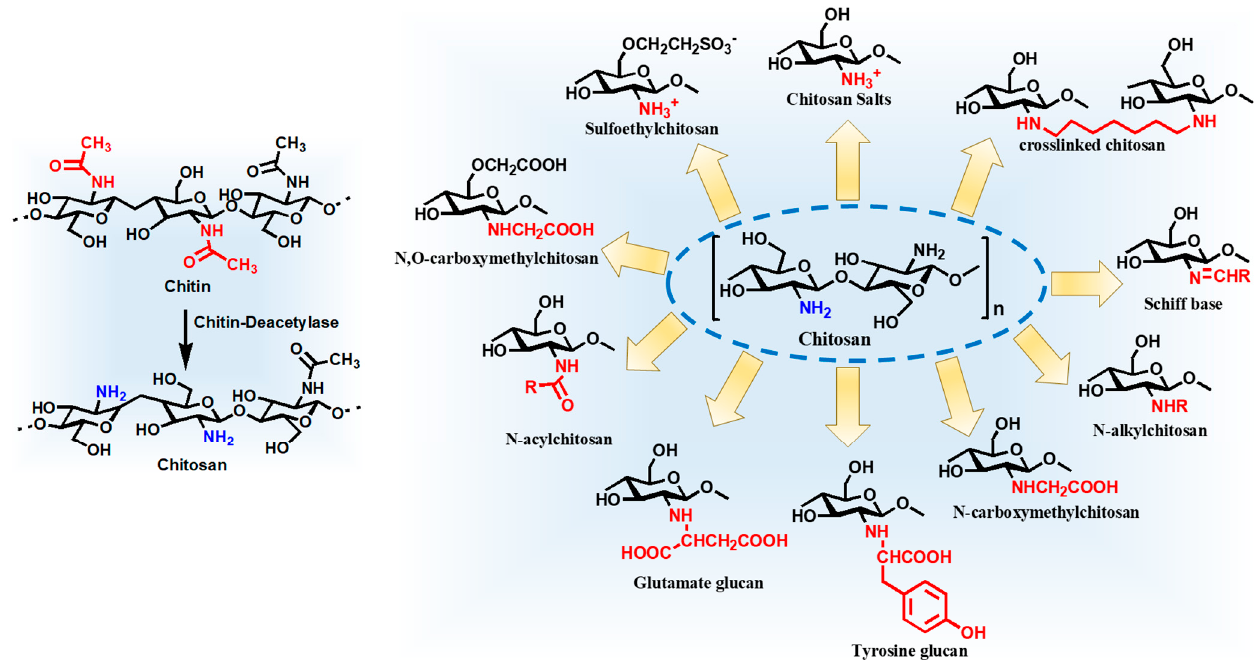
Figure 2. Synthesis of chitosan from chitin and structures of some of functionalized chitosan derivatives.